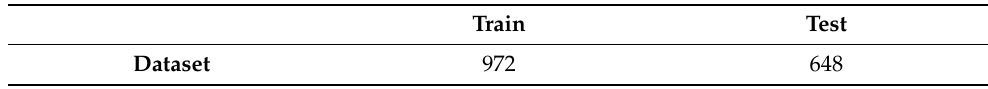
Table 2. Dataset from TCAD and MATLAB tools.